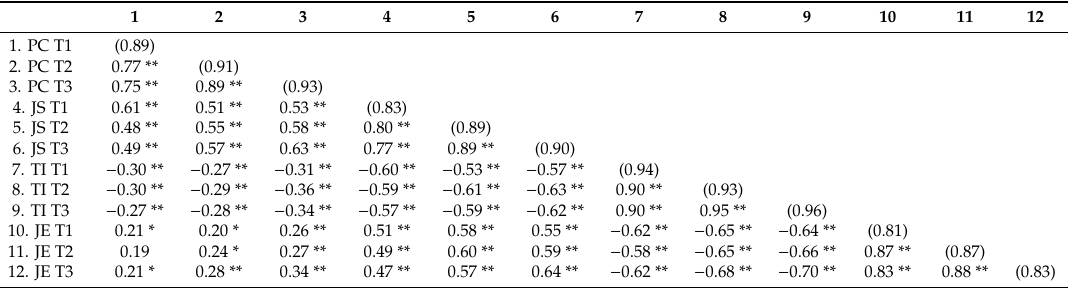
Table 1. Correlations and reliability of all study